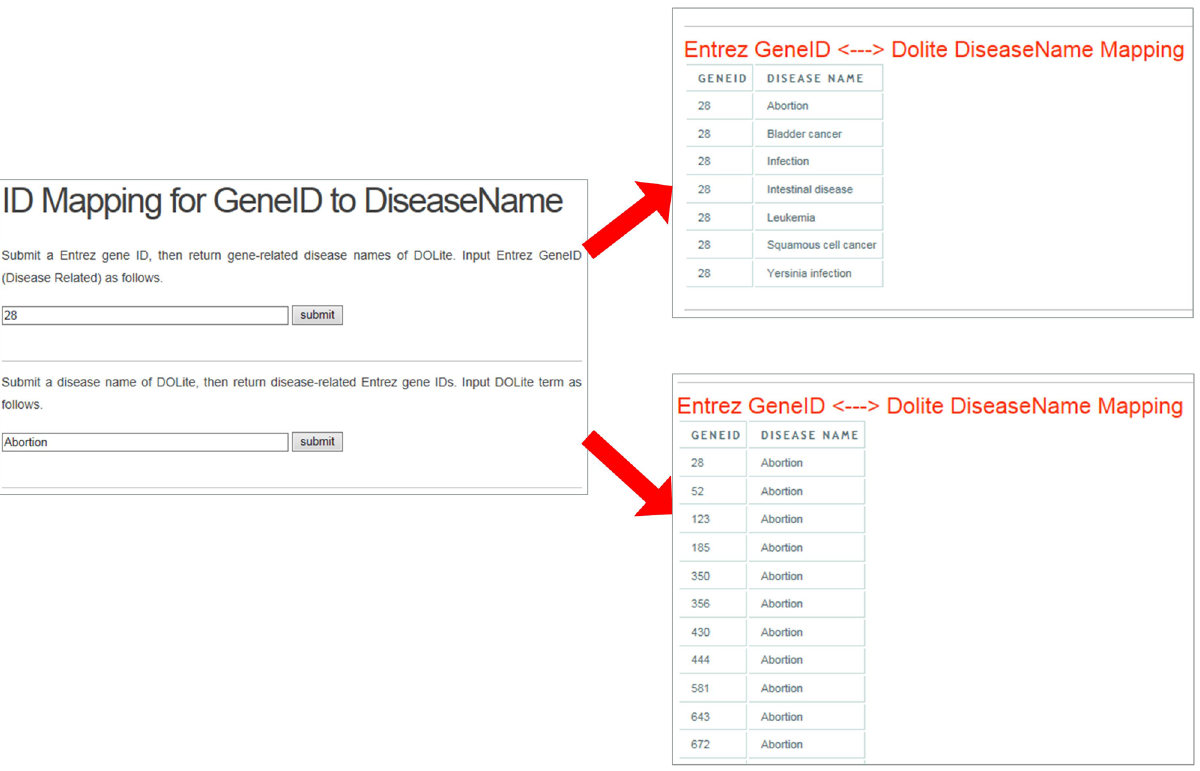
Fig 3. Schematic workflow of annotating human genes and